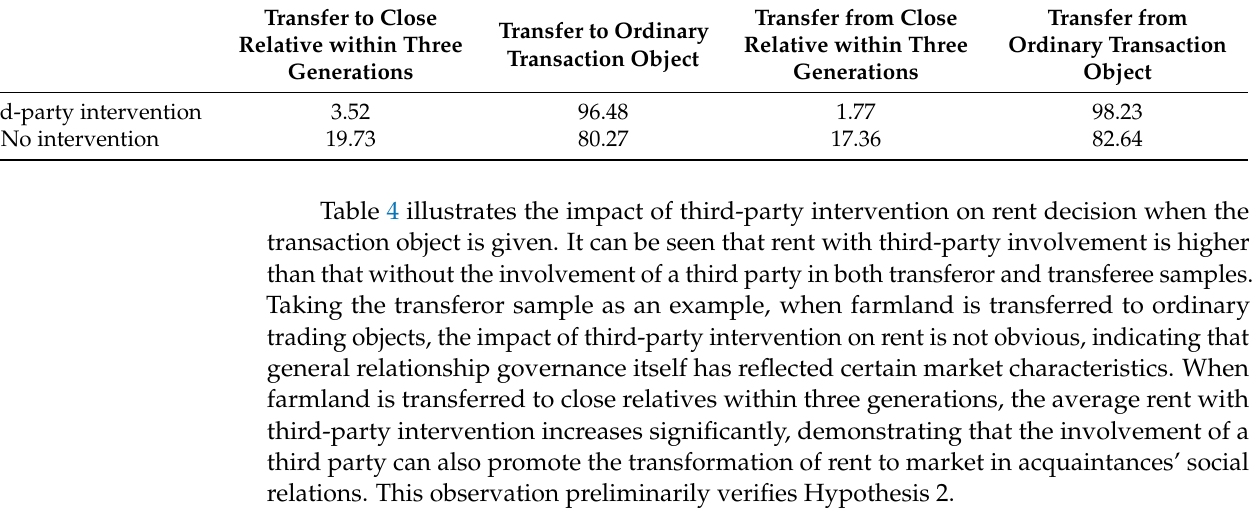
Table 4. Descriptive evidence of third-party intervention influencing